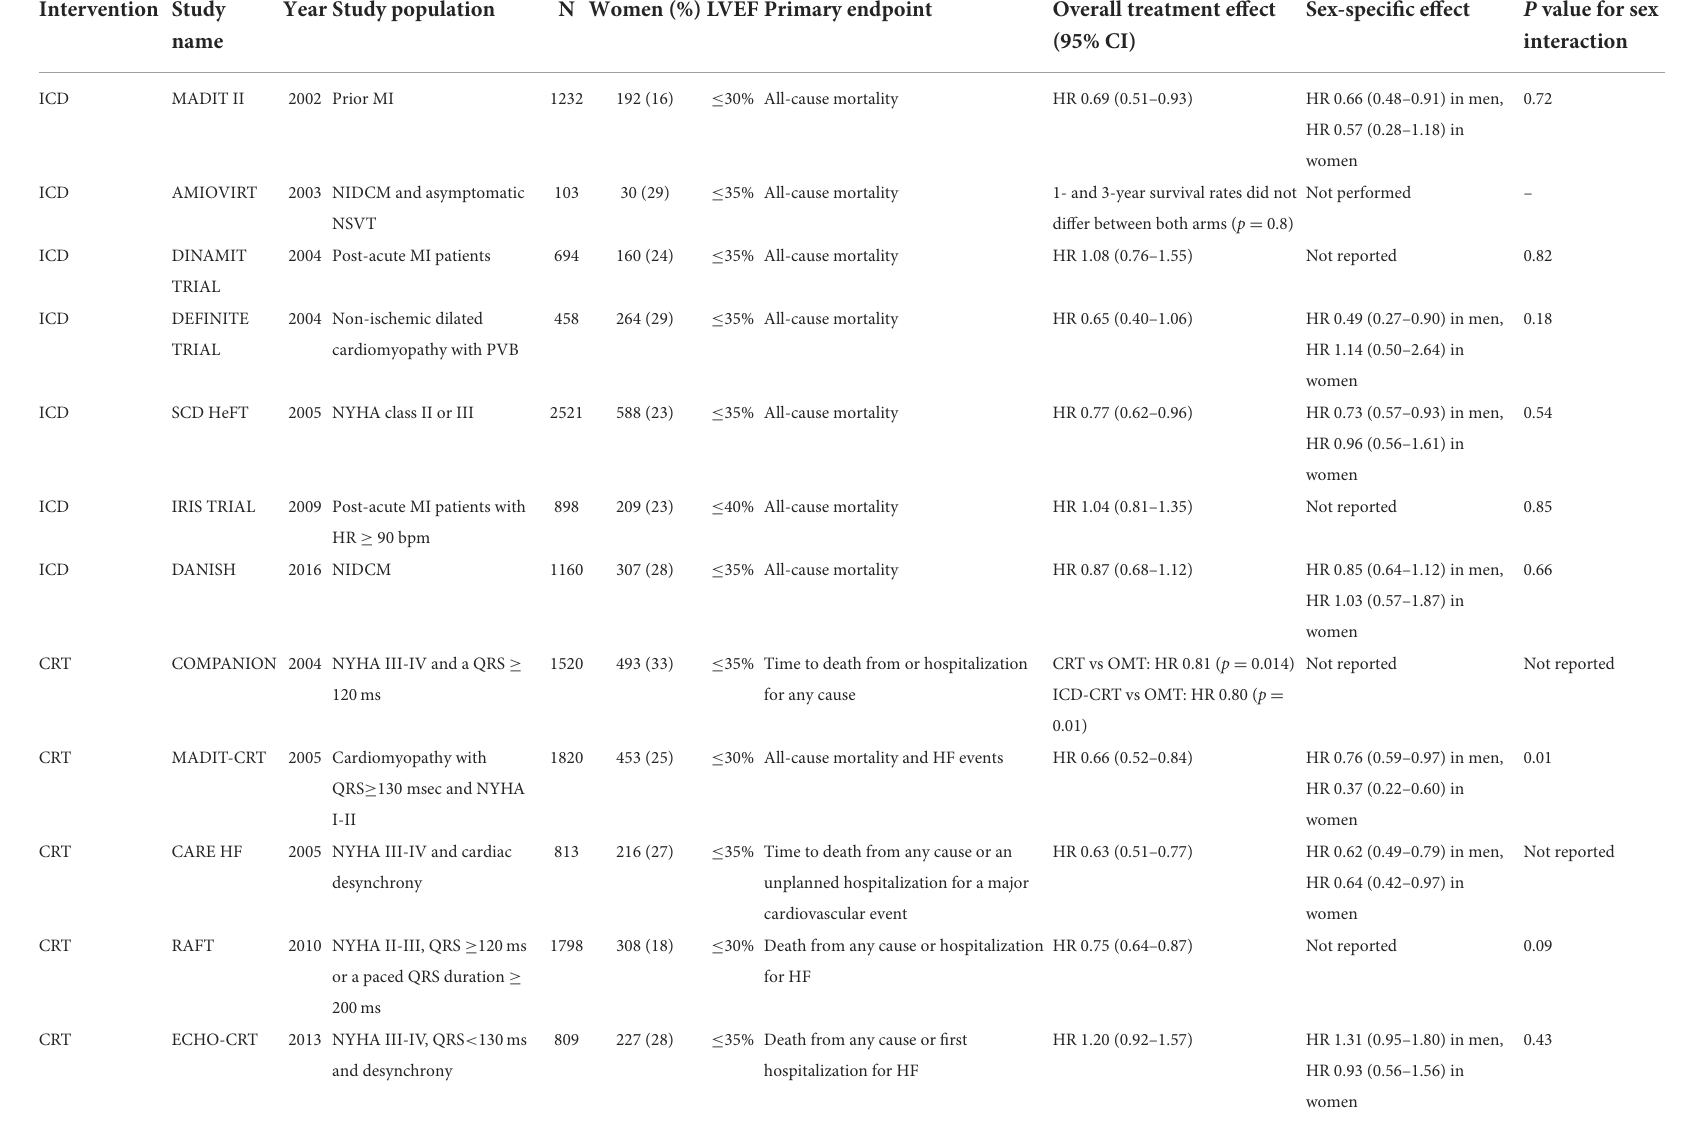
TABLE 2 Randomized clinical trials for ICD/CRT in HFrEF included in the systematic review. Intervention